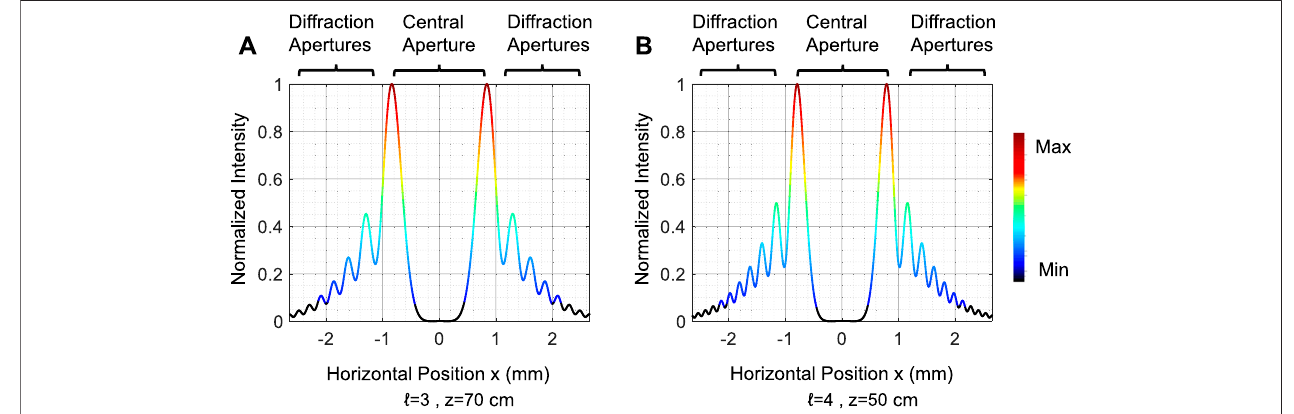
FIGURE3| Thecross-sectionalviewoftheintensityimagesat y =0for (A) ℓ =3, z =70 cmand (B) ℓ =4, z =50 cm.Thesizeofthecentralaperturesiscomparable in both images. However, the number of side lobes in the diffractive apertures is different. This subtle feature enables us to distinguish these two cases.